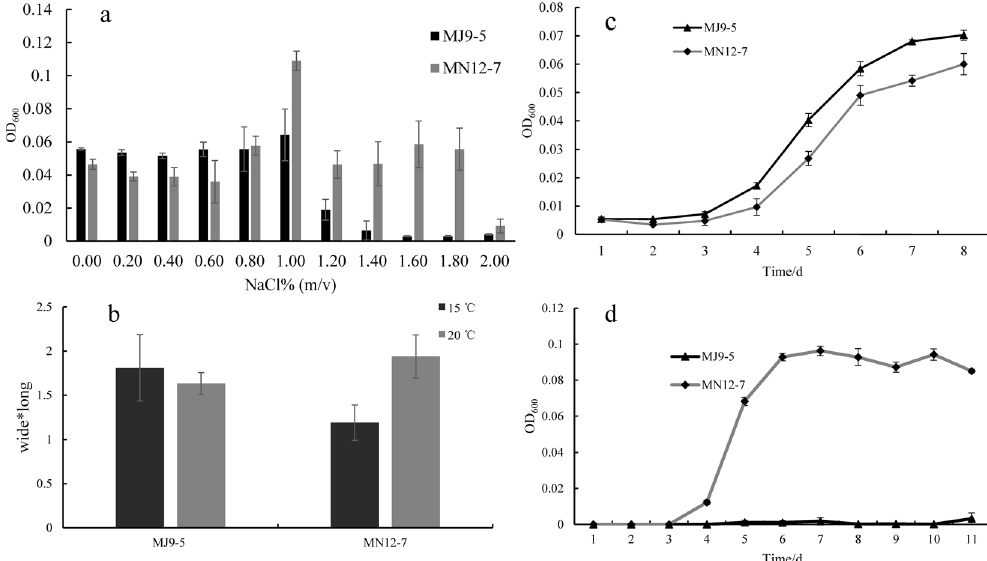
Figure 1. ( a ) NaCl tolerance of strains MJ9-5 and MN12-7 ( b ) cell sizes of strains MJ9-5 and MN12-7 after incubation at 15 °C and 20 °C; and growth of strains MJ9-5 and MN12-7 at ( c ) 4 °C and ( d ) 25